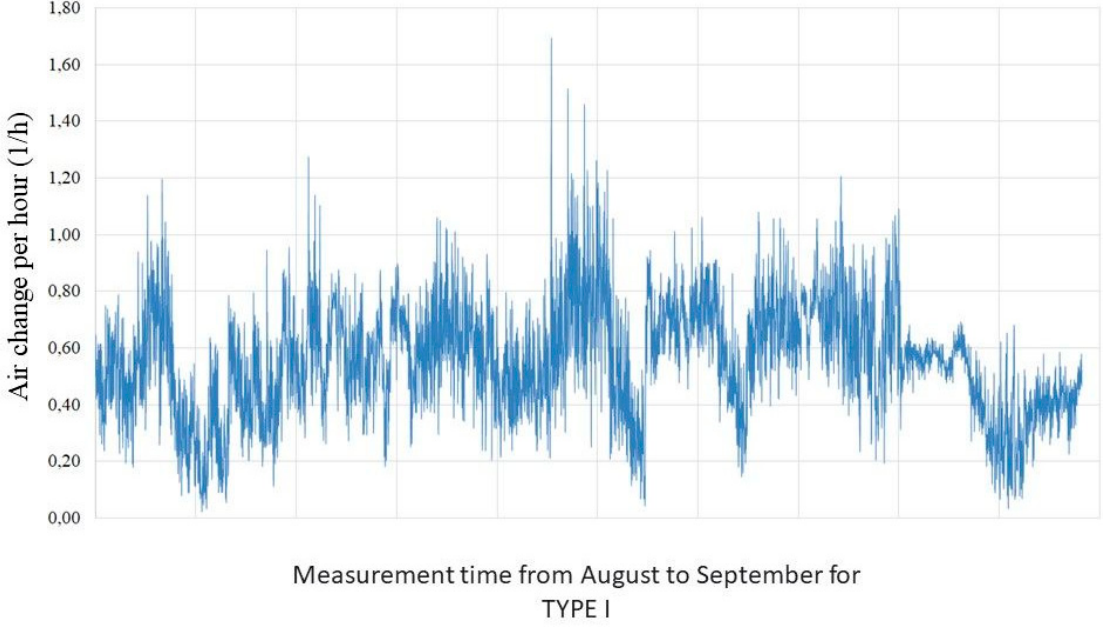
Figure 14. Gravity ventilationefficiency—chimney TYPE I. ACH measurement when the dominant mechanism was the solar radiation.